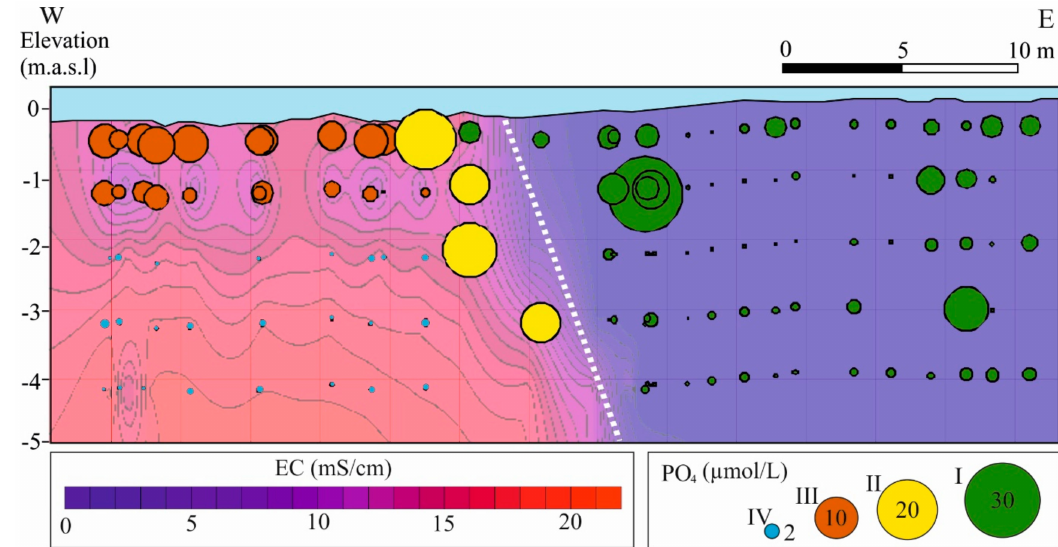
Figure 8. Bubble diagram of PO 4 concentrations measured in groundwater along the transect, together with interpolated EC. PO 4 concentrations have been plotted with di ff erent colors for the categories, as explained in the text (vertical scale ×